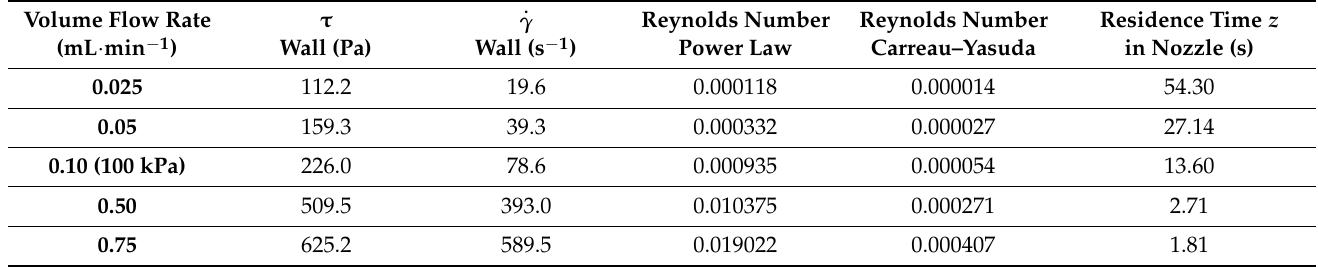
Table 4. Calculation of shear intensity, Reynolds number, and residence time at different flow rates in a G20 nozzle ( ∅ 600 µ m, 25 mm length, cylindrical). As reference for the printing process [12], the volume flow rate is presented for 37 ◦ C and 40 min cooling